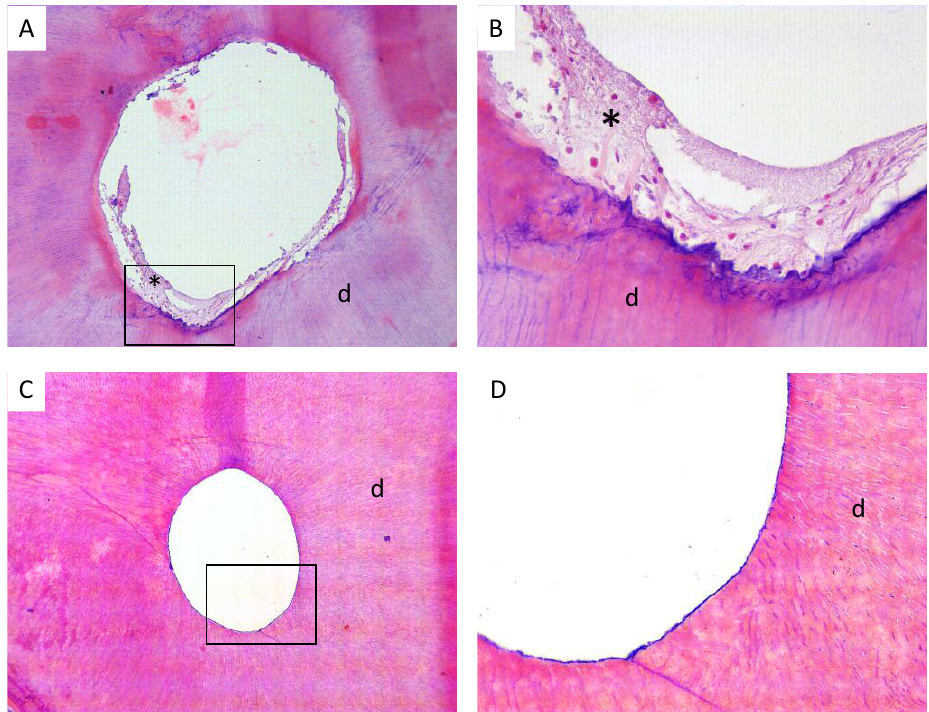
Figure 3. Representative images, at 2 mm from the apex, of root canals instrumented with RaCe system with and without PUI. ( A , B ): Root canals instrumented with RaCe system #25 without PUI. Organic remnant is observed adjacent to the walls of the apical canal. ( C , D ): Apical canals instru- mented with RaCe system #25 with PUI. The walls of the apical canal are observed without organic remnants. H&E staining. Magnification: ( A , C ), 10 × ( B , D ), 40 × * = organic remnant. d = dentin.